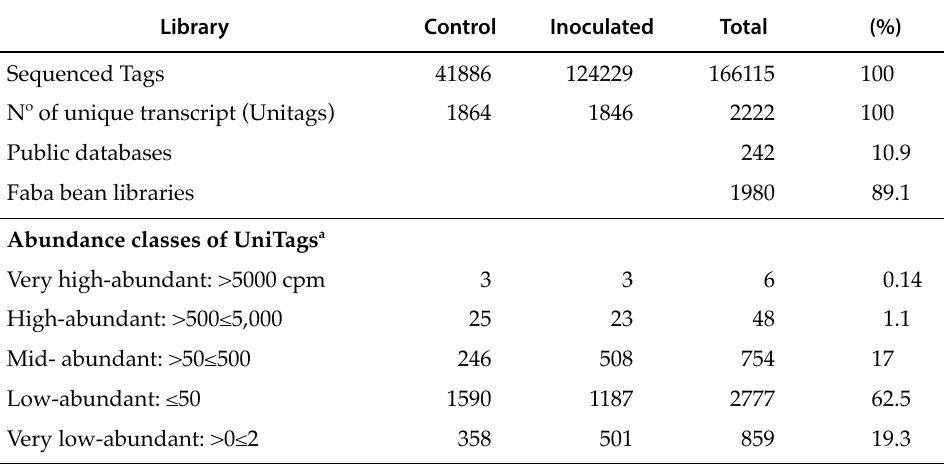
Table 1 . Features of SuperSAGE libraries from control and inoculated leaves.